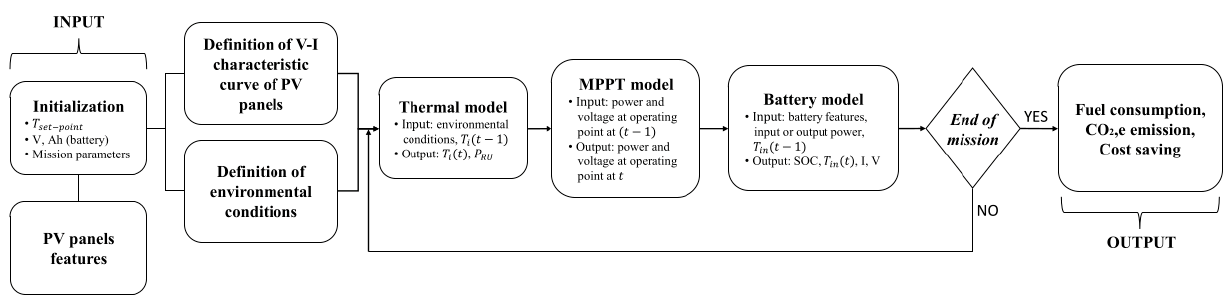
Figure 1. Model flow diagram.